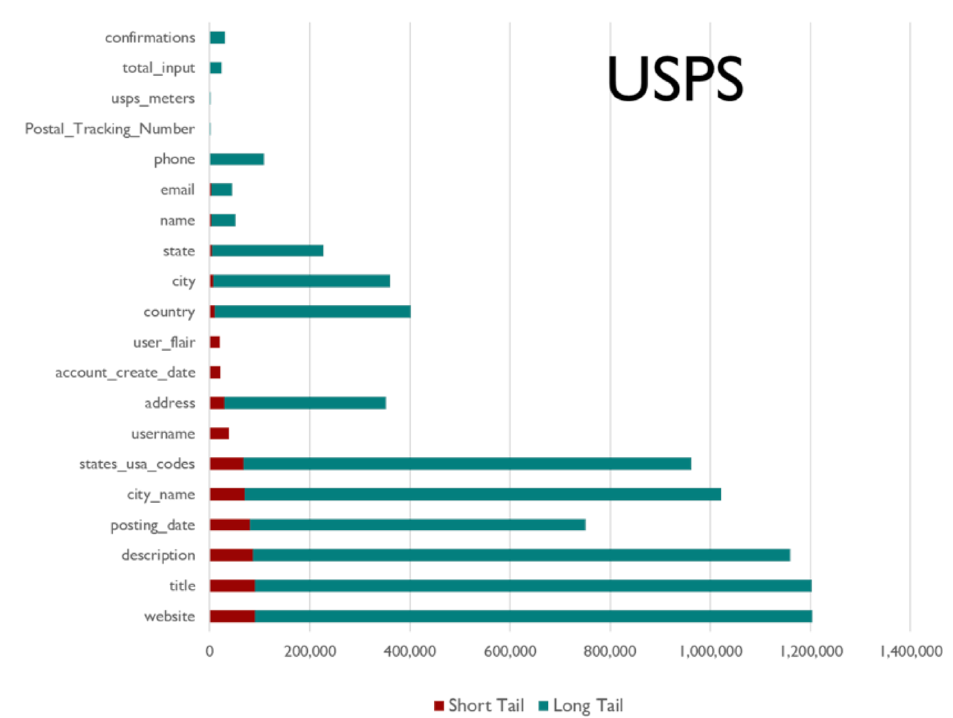
Figure 12. For the USPS domain, a comparison of web page count (x-axis) such that at least one value per field (y-axis) was extracted from that website (green bar/long tail), against the short tail/red bar wherein only Inferlink extractions are